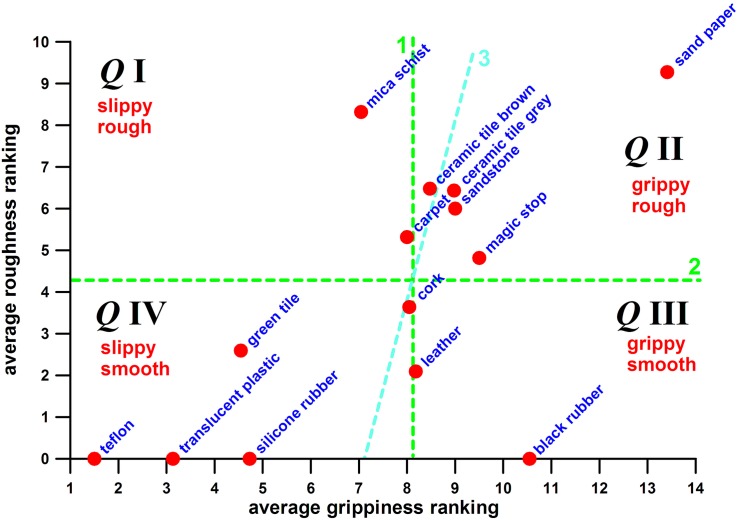
Hold surface property map, average roughness ranking vs. grippiness ranking; (QI–QIV) Quarters I to IV; (1) dashed line dividing the surfaces into a slippy and grippy half; (2) dashed line dividing the surfaces into a rough and smooth half; (3) tilted line 1 required for a more even distribution of the surfaces across the four quarters.